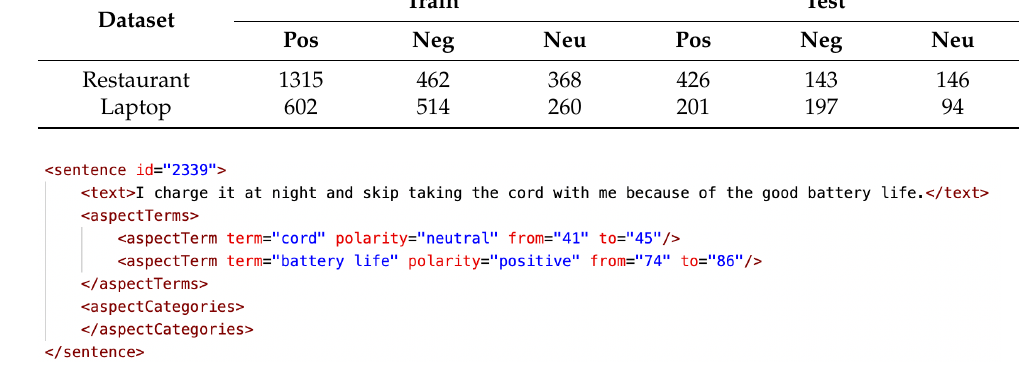
Figure 4. Example of benchmark